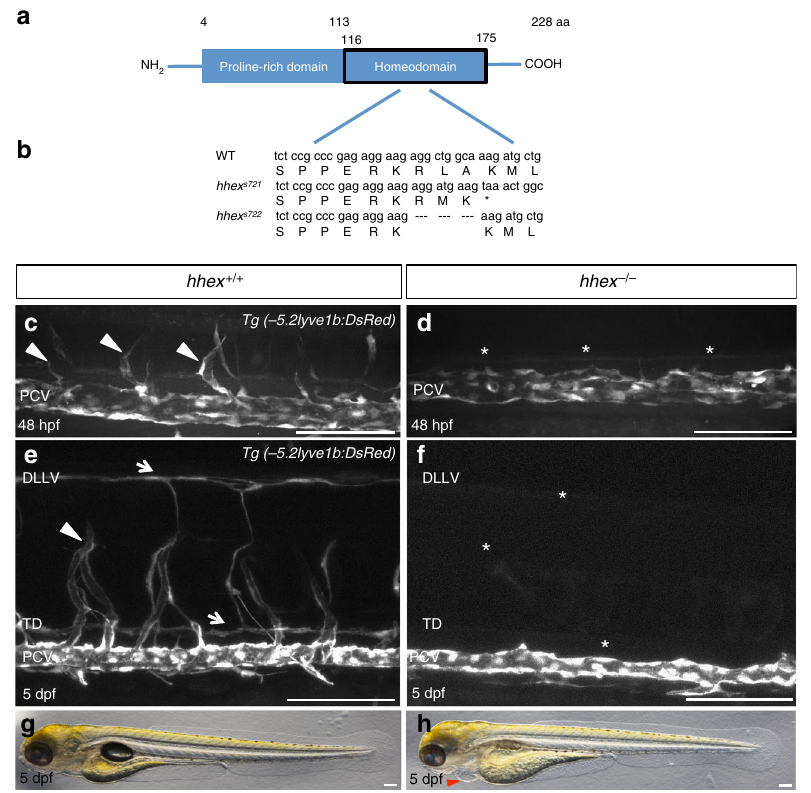
Fig. 1 Zebra fi sh hhex mutants lack sprouting angiogenesis from the posterior cardinal vein. a Schematic representation of Hhex. Hhex, 228 amino acids (aa) long, is composed of a proline-rich domain (4 – 113 aa) and a homeodomain (116 – 175 aa). b Alignment of partial Hhex homeodomain sequence in wild-type (WT), and two mutant alleles, hhex s721 and hhex s722 . The hhex s721 allele contains a 10 bp insertion leading to a premature stop codon within the homeodomain coding region, whereas the hhex s722 allele lacks amino acids R149 to A151. c , d Trunk vasculature of Tg( − 5.2lyve1b:DsRed) ; hhex + / + and hhex − / − embryos at 48 hpf. hhex mutant trunks exhibit a defect in sprouting angiogenesis from the posterior cardinal vein (PCV) (arrowheads point to tip cells sprouting from the PCV; asterisks indicate lack of tip cells sprouting from the PCV). e , f Trunk vasculature of Tg( − 5.2lyve1b:DsRed) ; hhex + / + and hhex − / − larvae at 5 dpf. hhex mutant trunks exhibit a defect in the formation of the venous intersegmental vessels (vISVs), the thoracic duct (TD) lymphatic vessel, and the dorsal longitudinal lymphatic vessel (DLLV) (arrowhead points to a vISV; arrows point to the ventrally positioned TD and dorsally positioned DLLV; asterisks indicate lack of these structures). g , h Bright fi eld lateral views of hhex + / + and hhex − / − larvae at 5 dpf. Mutant larvae exhibit pericardial edema (arrowhead). Scale bars: 100 μ